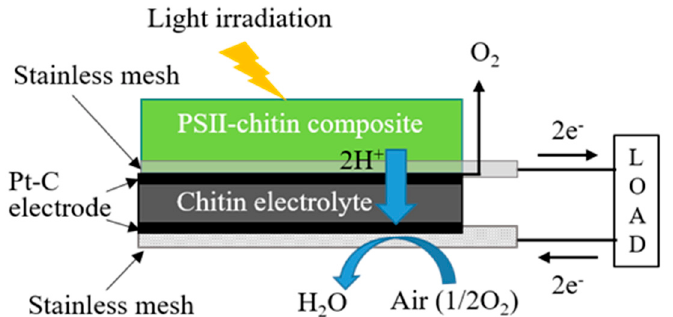
Figure 3. Structure of the biofuel cell using the chitin electrolyte and the PSII–chitin composite hydrogen fuel.